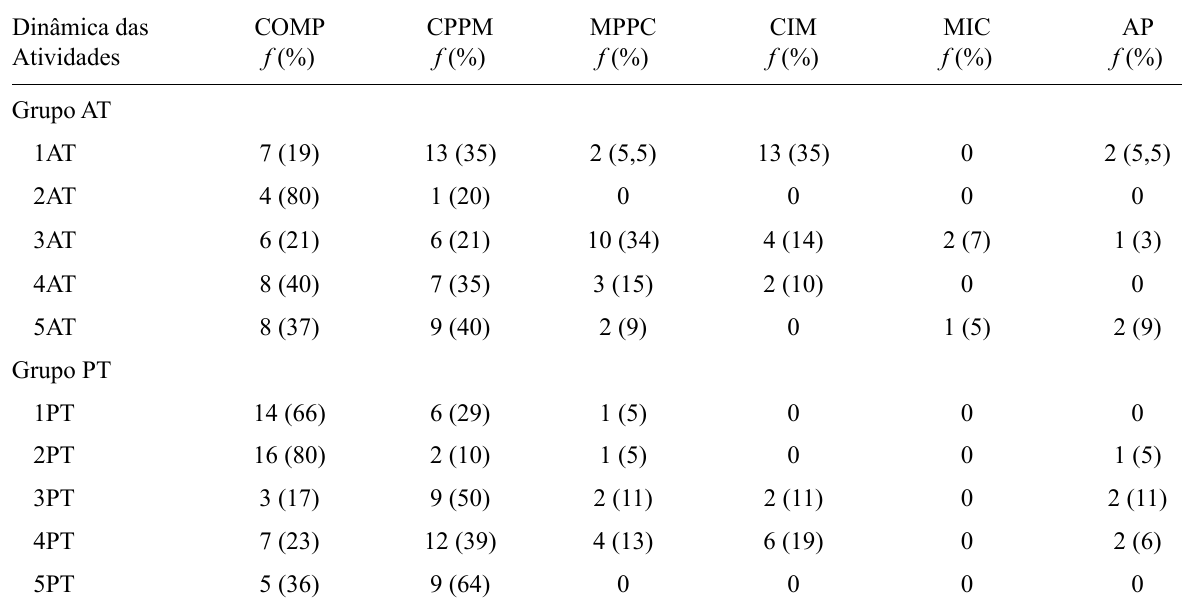
Frequência e Porcentagem das Dinâmicas das Atividades Desenvolvidas na Interação Mãe-Criança no Grupo de Crianças Nascidas A Termo (Grupo AT) e Pré-Termo (Grupo PT)